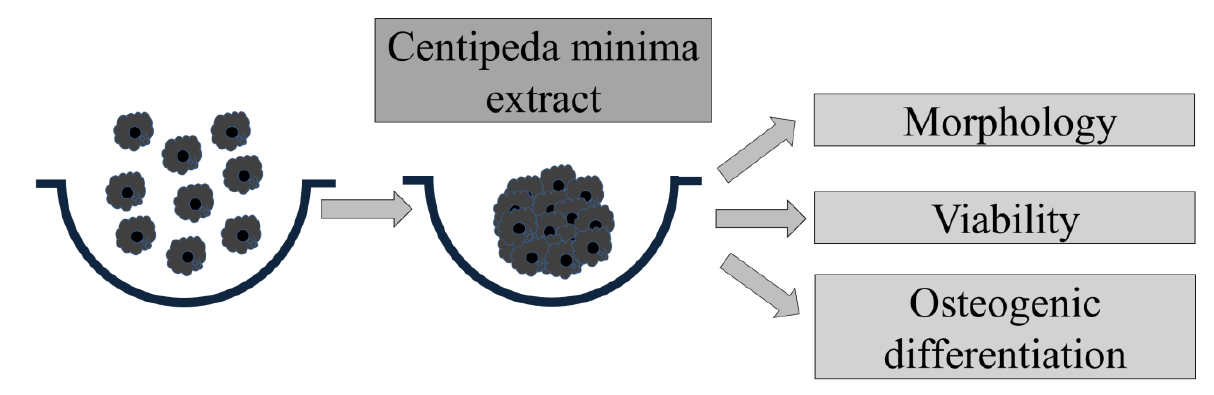
Figure 1. An illustration of the design of the current study.